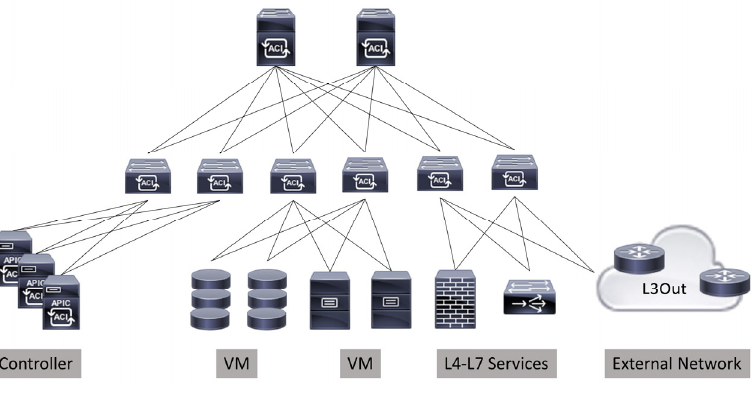
Figure 6. Logical design of SDN and